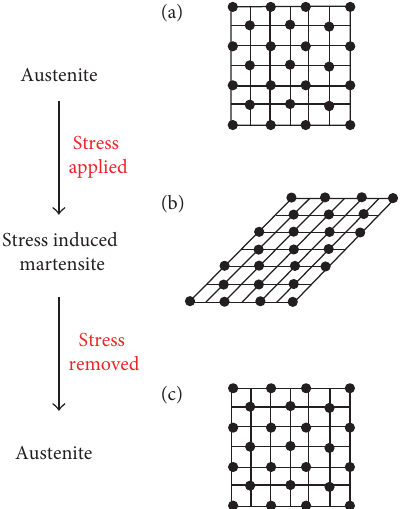
Figure 2: Mechanism of superelasticity when test temperature is above 𝐴 𝑓 . (a) Austenite at test temperature. (b) Stress induced martensite upon application of stress. (c) Austenite upon removal of stress. Change in lattice structure with phase transformation is given in Figure 8 of